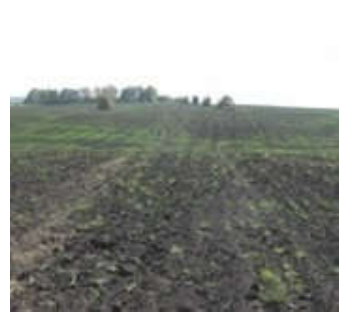
Figure 3 . A dry streambed on a plowed field with winter crops (photo made on September 05, 2014).